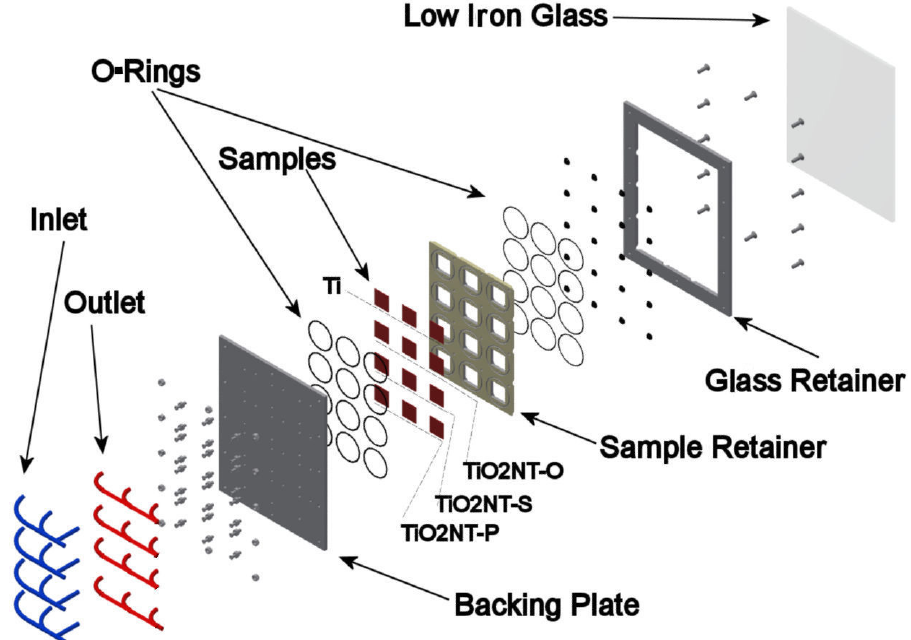
Figure 2. Exploded view of sample cell